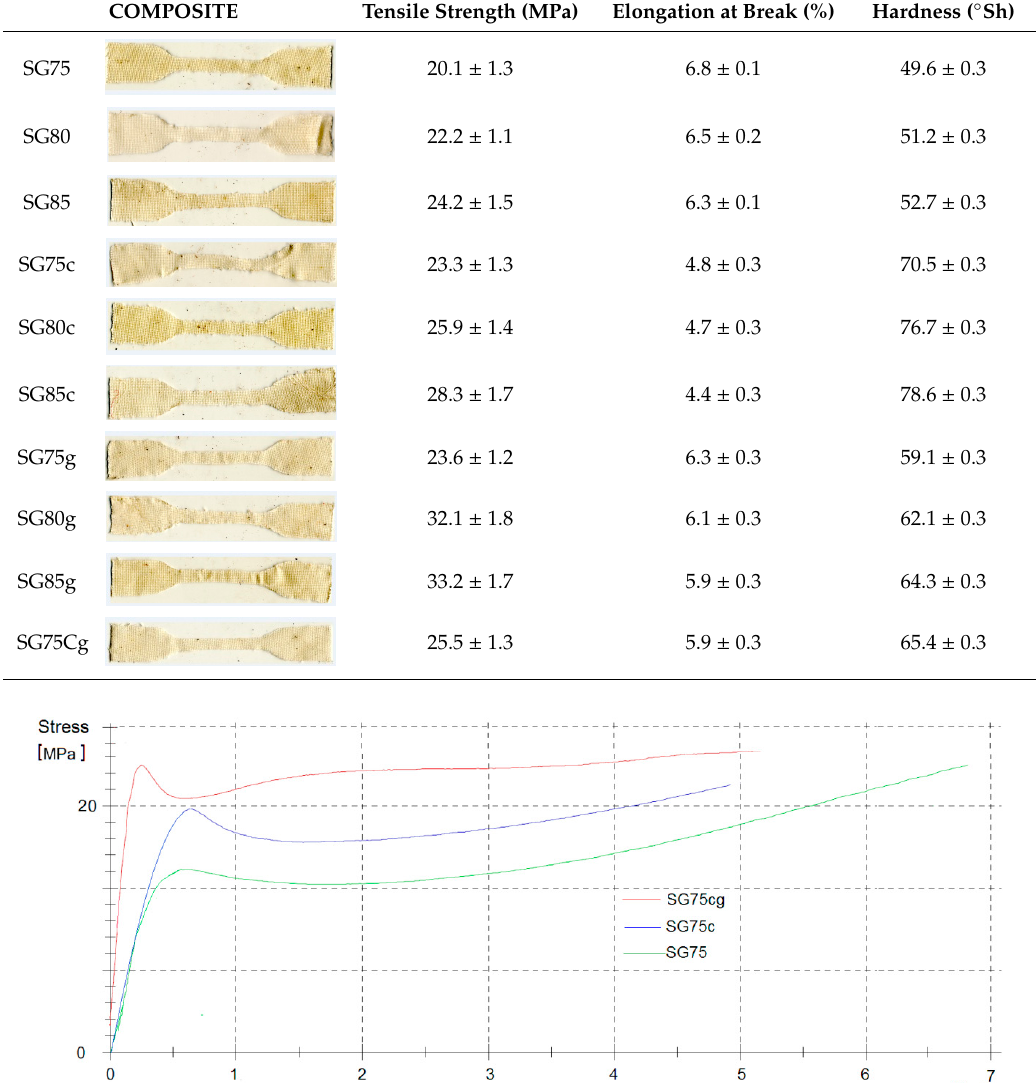
Table 3. Effect of the impact of starch and glycerin content and of the addition of casein or gelatin on the mechanical properties of cellulose-starch composites.